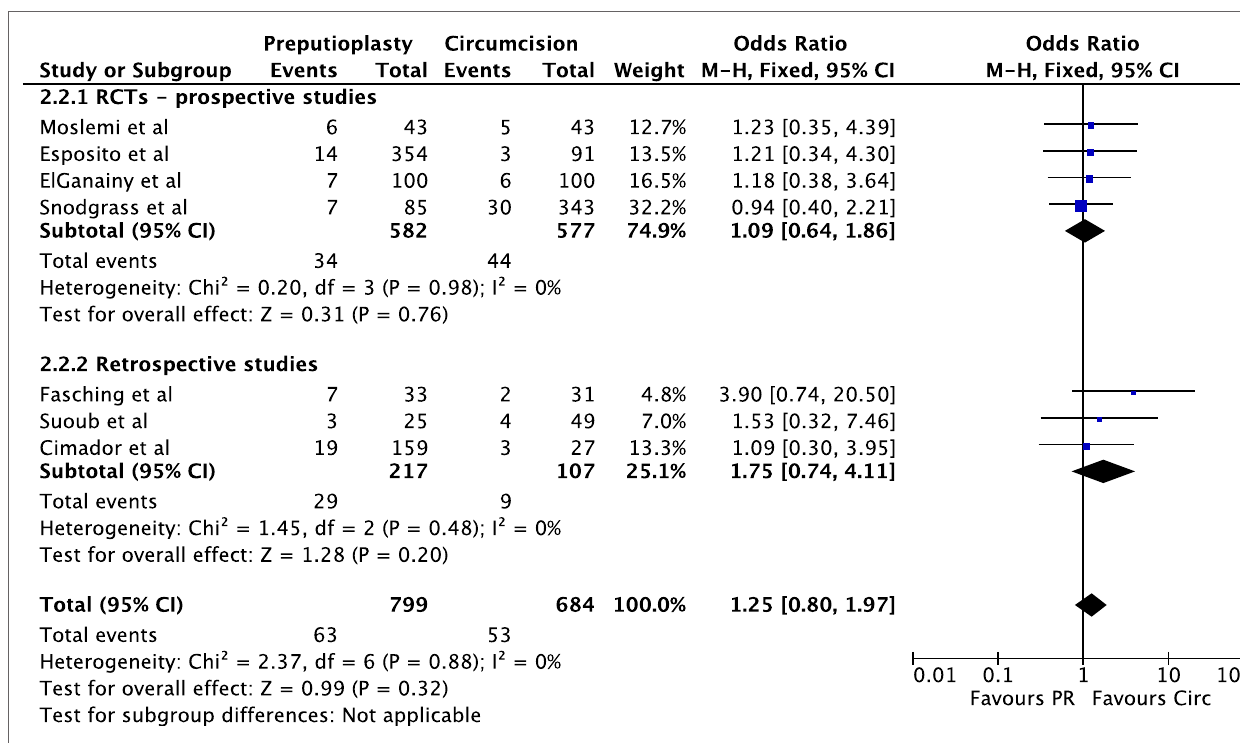
FigUre 2 | Forest plot comparing preputioplasty vs. circumcision for the outcome hypospadias fistula formation .